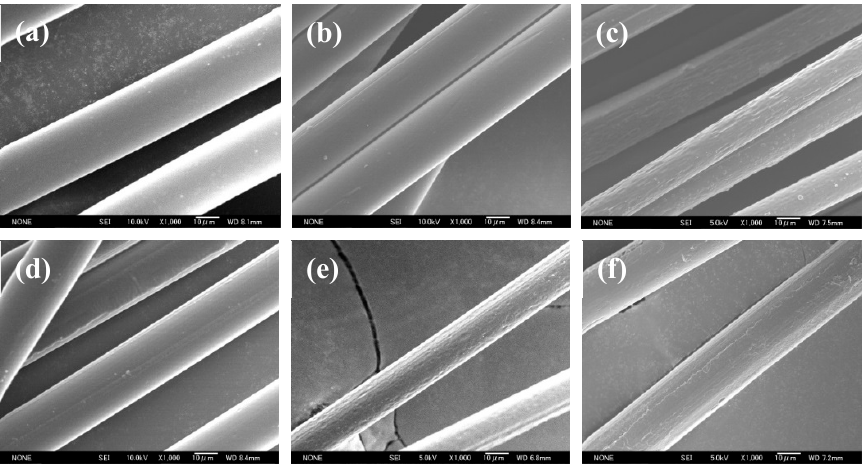
Figure 2. SEM images of PLA fibers: ( a ) original PLA fiber; ( b ) P-1; and ( c ) P-2; and CS-PLA ( d ) P-3; ( e ) P-4 and ( f ) P-5.